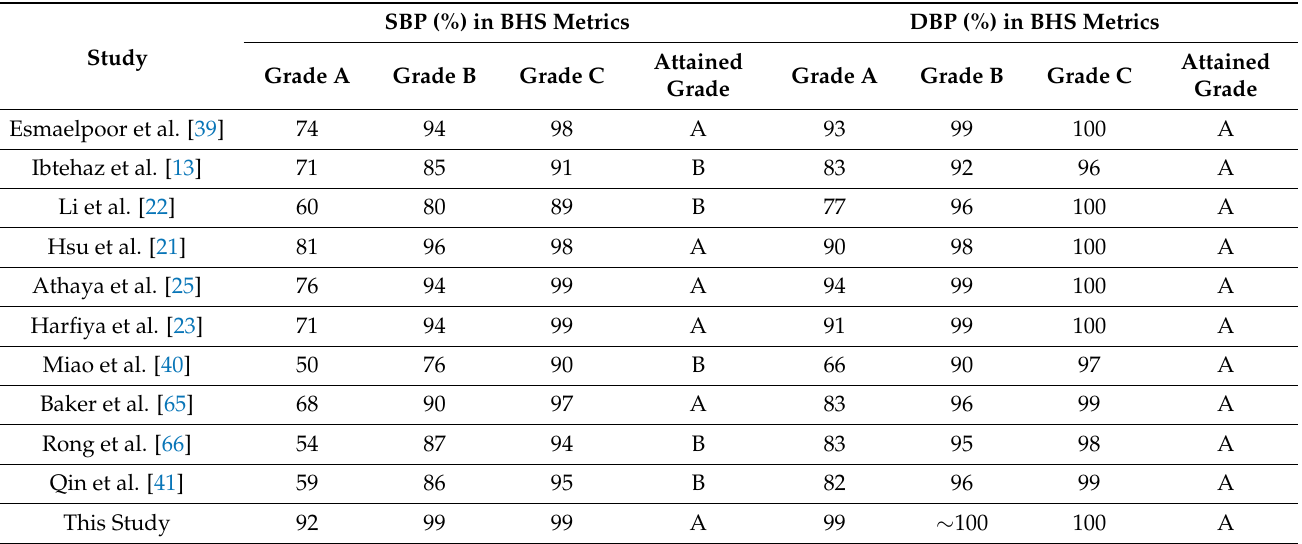
Table 12. Comparison of past studies based on their performance of BHS